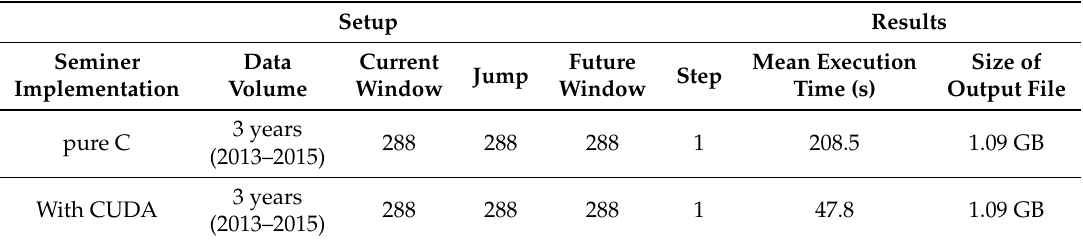
Table 8. SS CUDA implementation: Experiments and